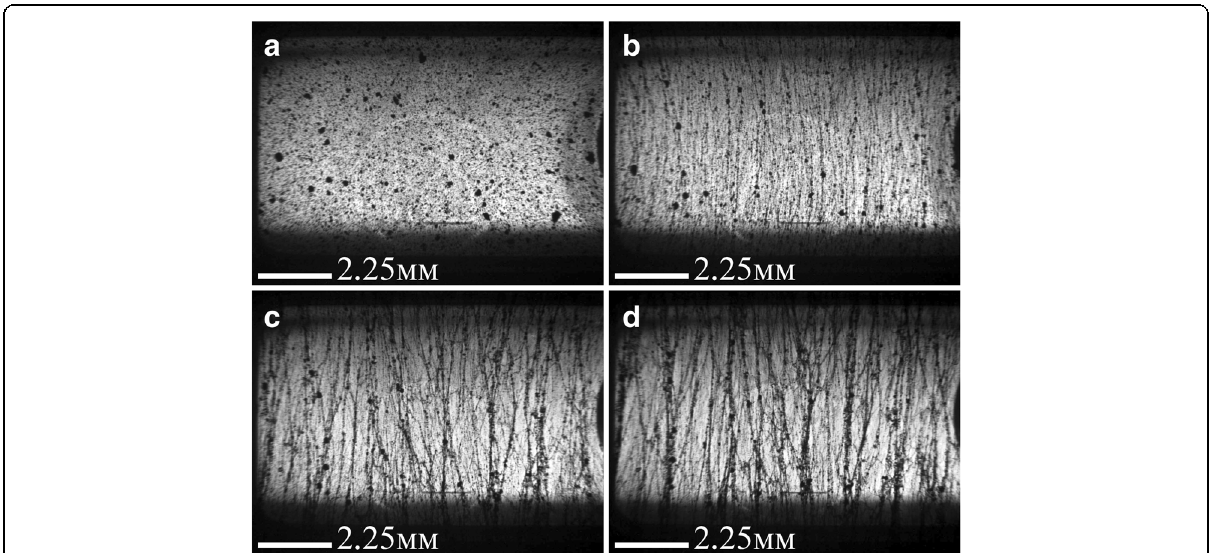
Fig. 3 Optical images of 0.05 wt.% MWCNTs/Larit 285 composite under AC electric field action (frequency of 15 kHz, strength of 83.3 kV/ m) (embedded electrodes): a – before electric field action; b – after 12 min; c – after 26 min; d – after 60 min of electric field action. Image size 10,8 × 8,0 mm 2 [26]